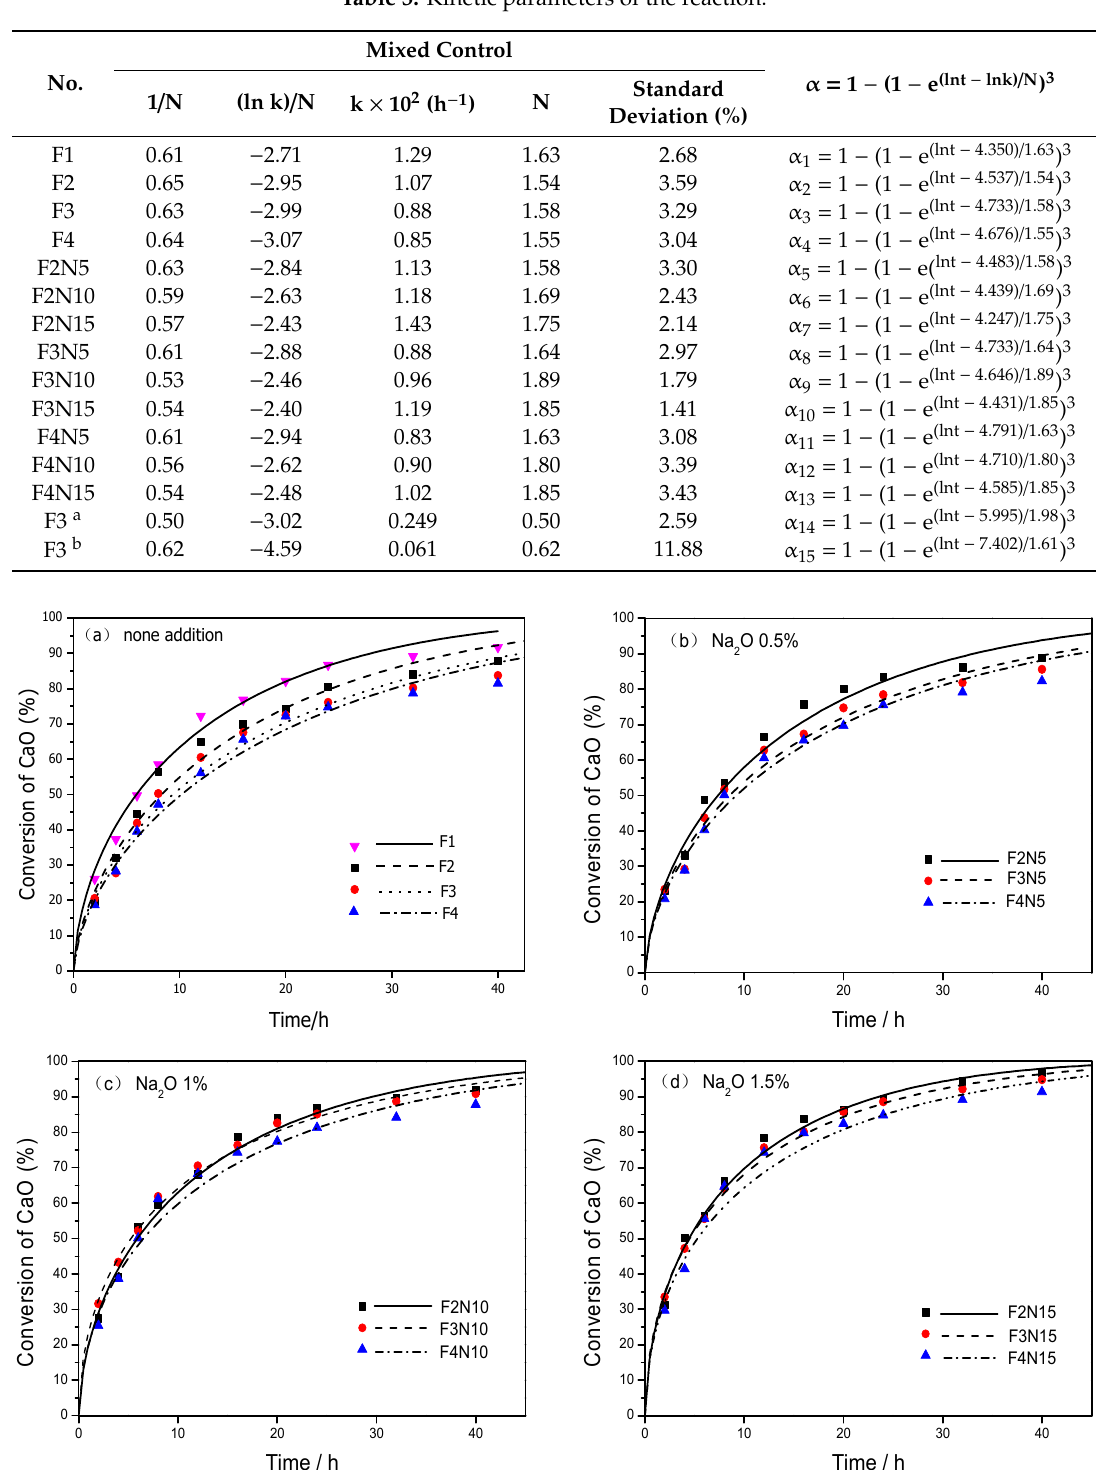
Table 3. Kinetic parameters of the reaction.